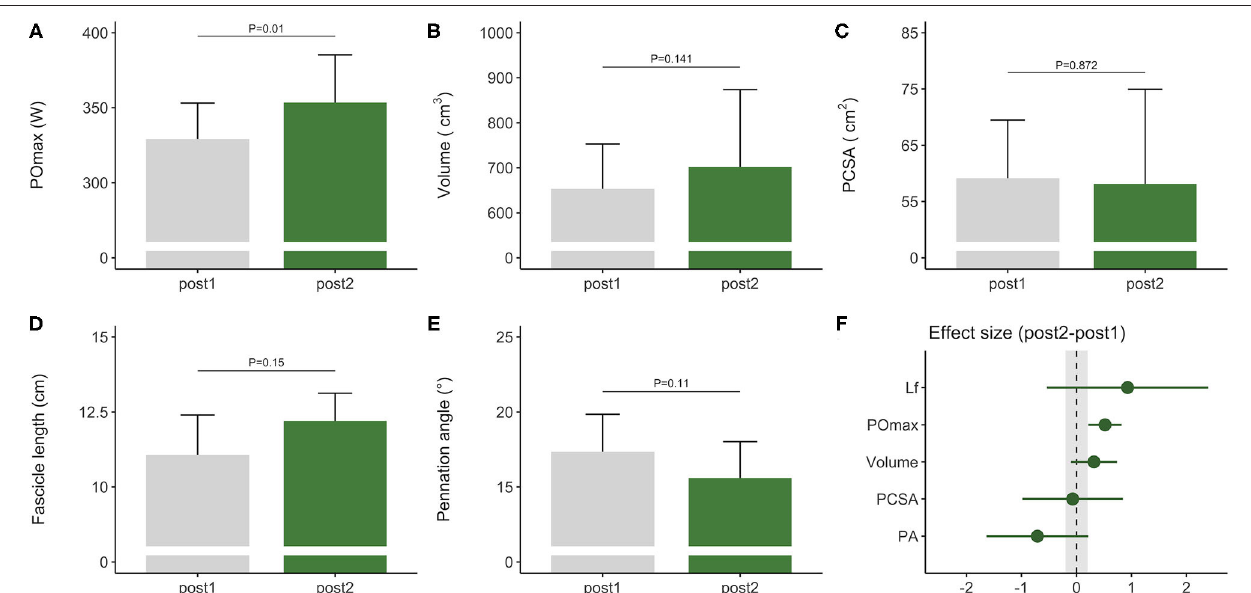
FIGURE 2 | Morphological and functional responses to the competitive preparation phase in a subgroup of elite female rowers. Functional response is shown for (A) maximal power output obtained on a rowing ergometer during concurrent training with additional plyometric loading. Morphological responses are shown for m. vastus lateralis (B) volume, (C) PCSA, (D) fascicle length, and (E) pennation angle. Standardized ESs and their 95% confidence intervals (in Cohen’s d ) are reported in (F) for the pre–post differences. The gray area in (F) highlights the smallest worthwhile change (|ES| 0.2), illustrating what effects can considered to be non-trivial. = PCSA, physiological cross-sectional area; POmax, rowing ergometer power output in the final 4min of a maximal incremental test; Lf, fascicle